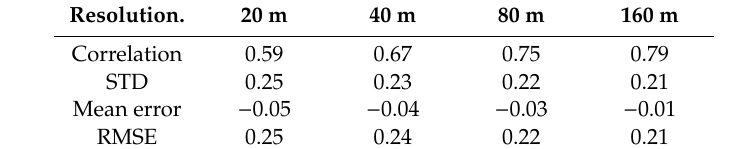
Table 9. Evaluation of the Sentinel-2 FSC against the SPOT validation dataset at different resolutions. Resolution.